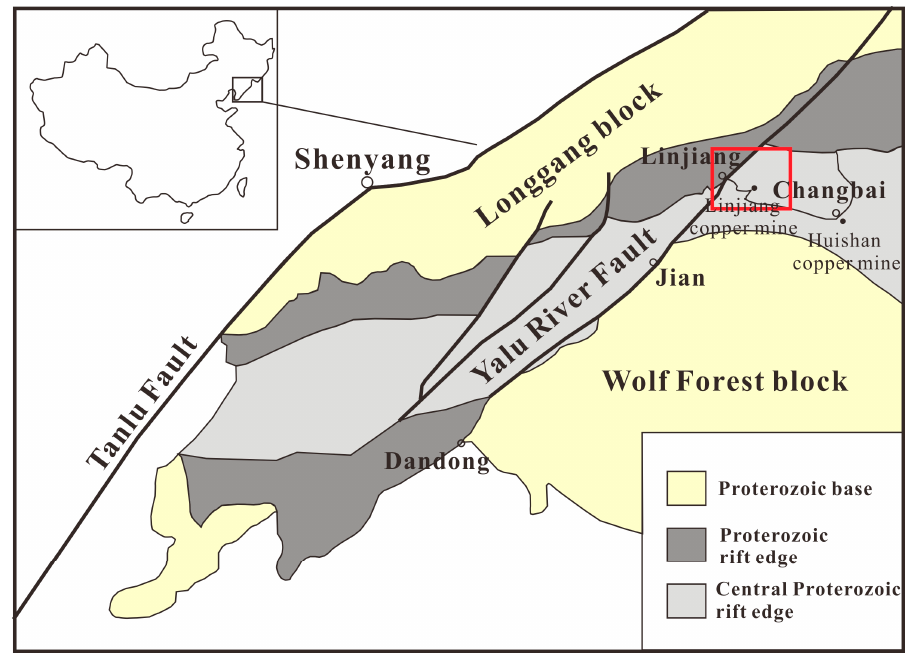
Figure 10 . Location (red rectangle) and tectonic background map of the study area. Figure 10. Location (red rectangle) and tectonic background map of the study